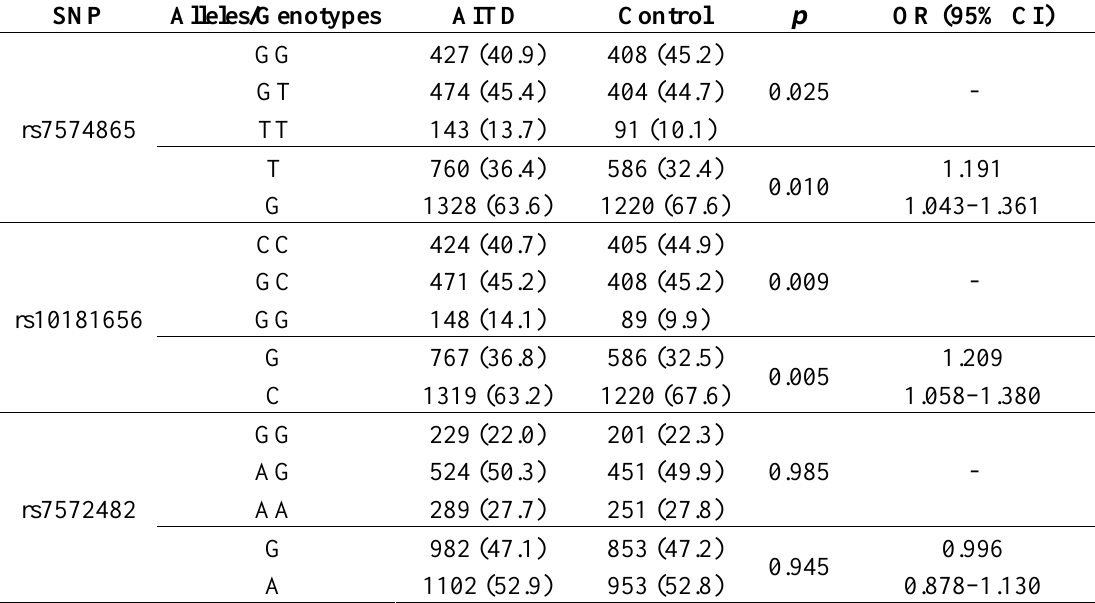
Table 2. Analysis of genotype and allele distribution of three STAT4 SNPs in AITD (autoimmune thyroid disease) patients and controls. OR: odds ratio; CI: confidence